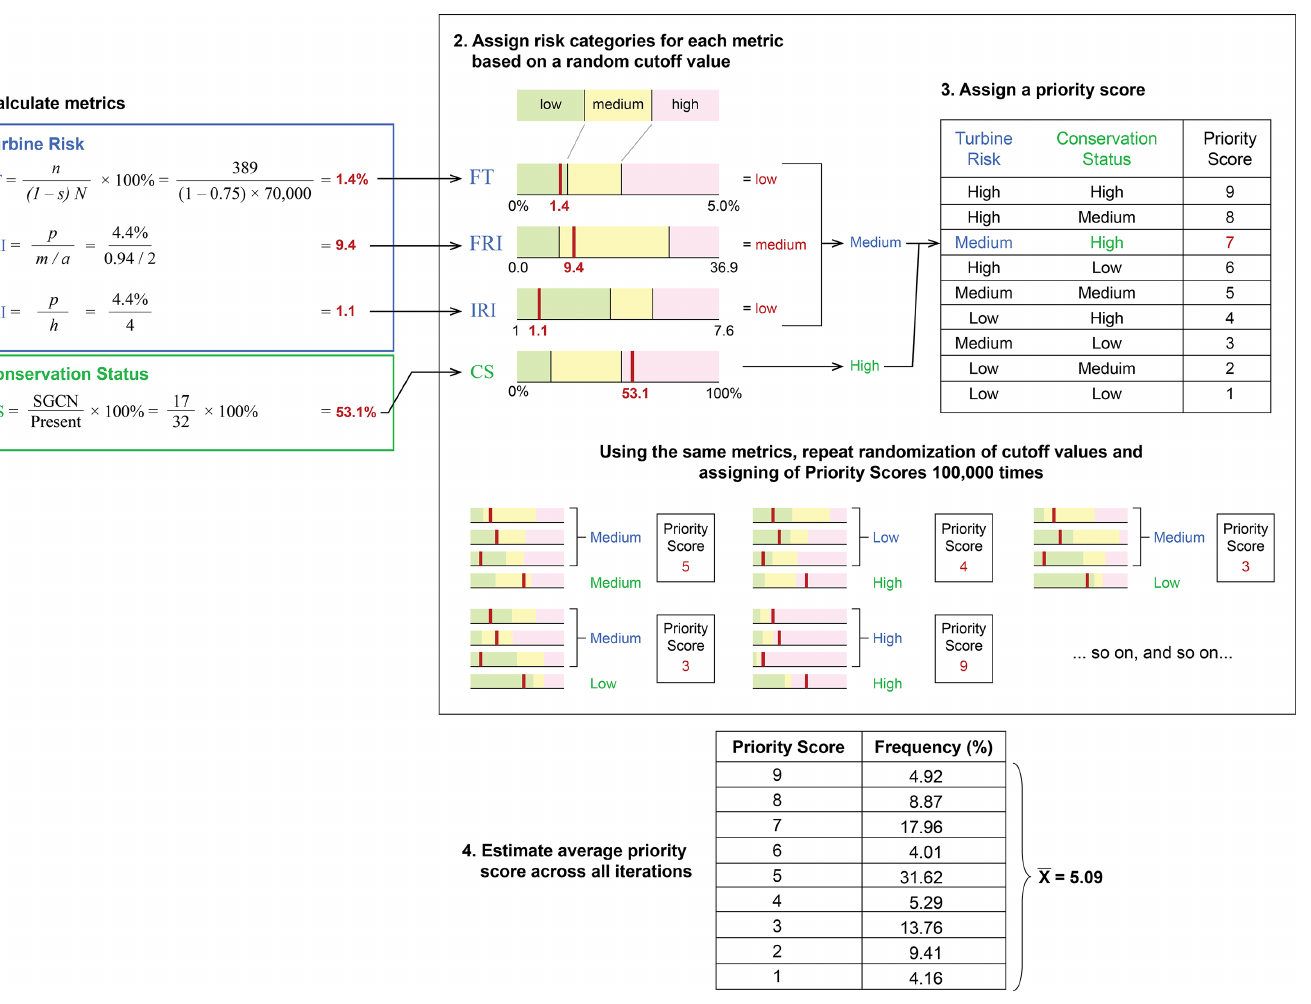
Fig 1. Prioritization work-flow. Prioritization for each species (in this example, the ferruginous hawk) begins with the calculation of 3 turbine risk metrics and 1 conservation status metric. Then random cutoff values are repeatedly drawn to assign each metric value to a low, medium, or high category. These categories are used to determine a priority score for each iteration, which can be summarized across all